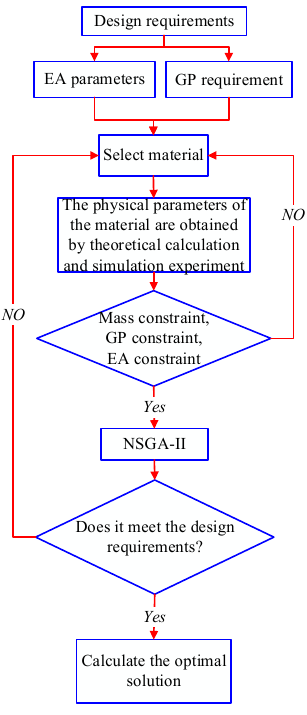
Figure 2. Flowchart of the optimization design.